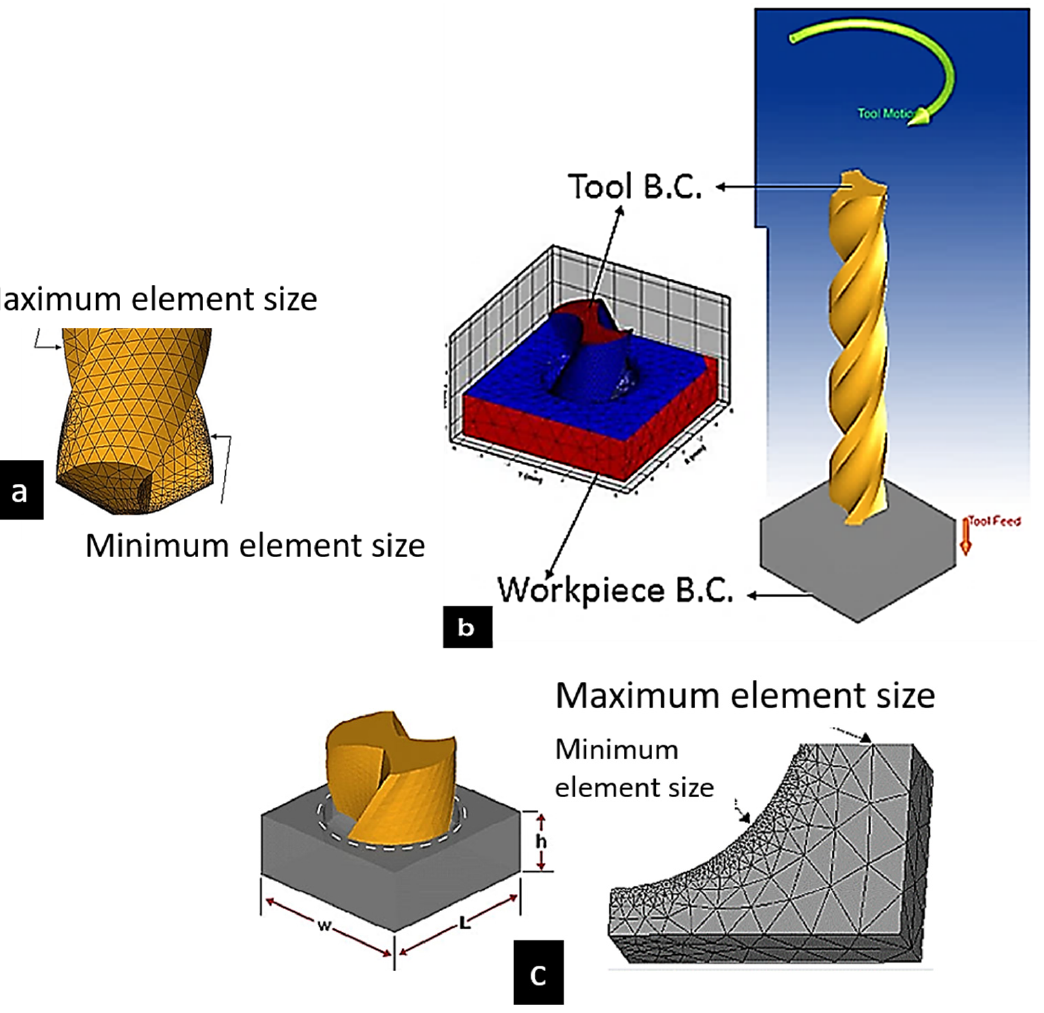
Figure 3. ( a ) FE tool in mesh condition. ( b ) Workpiece and tool boundary conditions. ( c ) Workpiece under meshing condition.